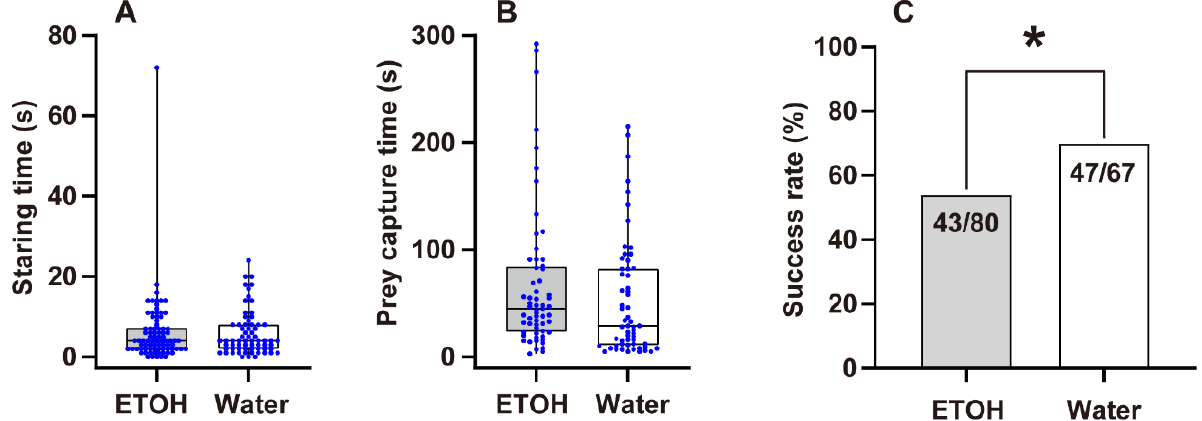
Figure 3. Prey capture efficiency of Myrmarachne gisti , showing ( A ) the time spiders spent staring at prey (females: N = 85; males: N = 67), ( B ) the time taken to capture prey (females: N = 68; males: N = 53), and ( C ) the success rate of their first attack. Boxplots show the data as jittered dots, with the box indicating the interquartile range (IQR), the whiskers showing the range of values that are within 1.5 × IQR, and a horizontal line indicating the median. ‘ * ’ indicates a significant difference ( p < 0.05).